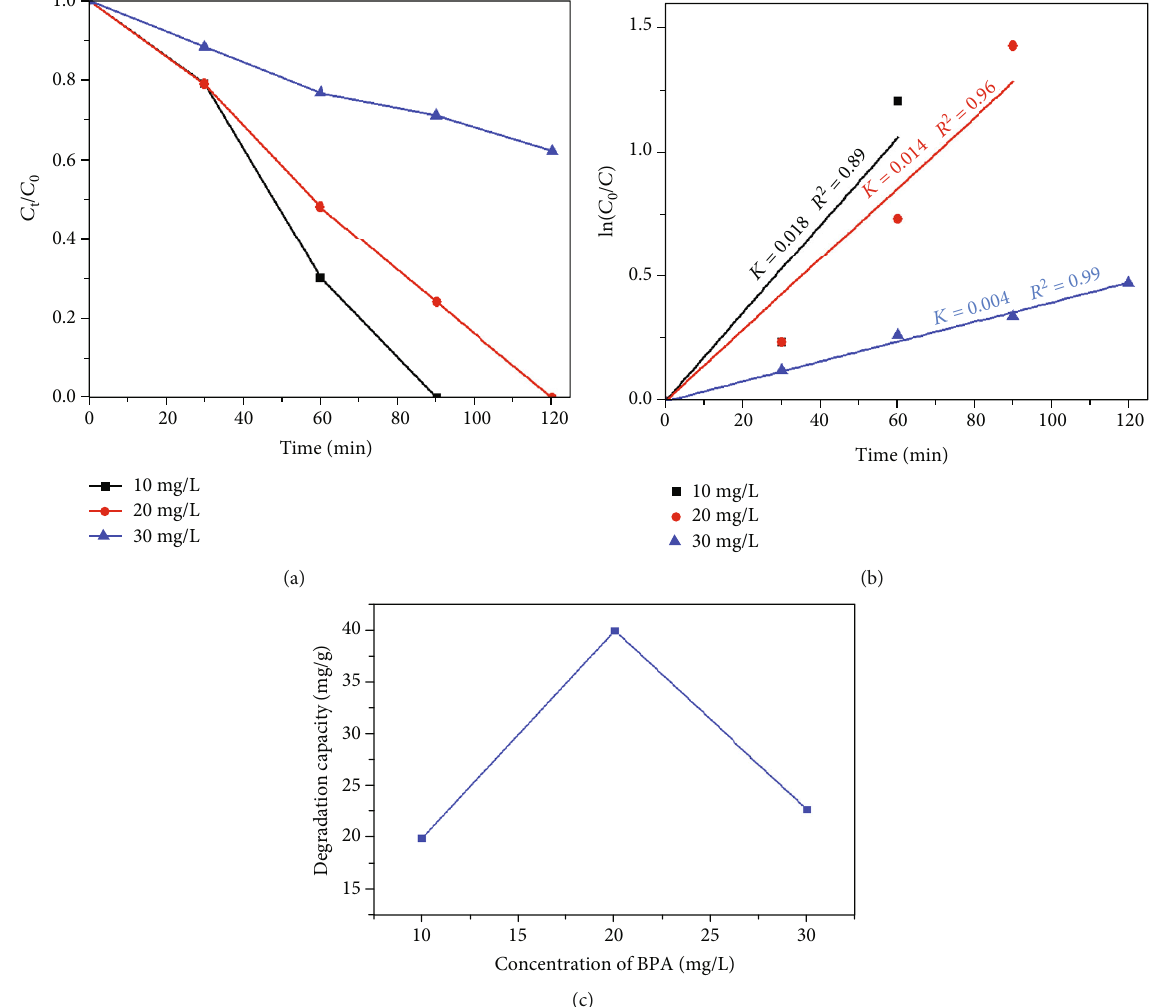
Figure 9: (a) E ff ect of concentration of BPA on photocatalytic activity, (b) the kinetic curves, and (c) degradation capacity versus concentration of BPA. The reaction conditions are as follows: dosage catalyst of 0.05 g and pH = 6 : 0